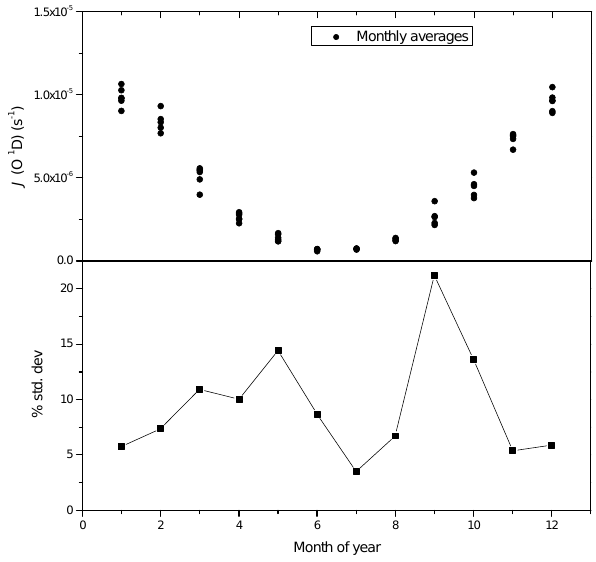
Figure 3. Annual cycle of J (O 1 D). The bottom panel shows the scatter in the monthly values as a percentage of the monthly